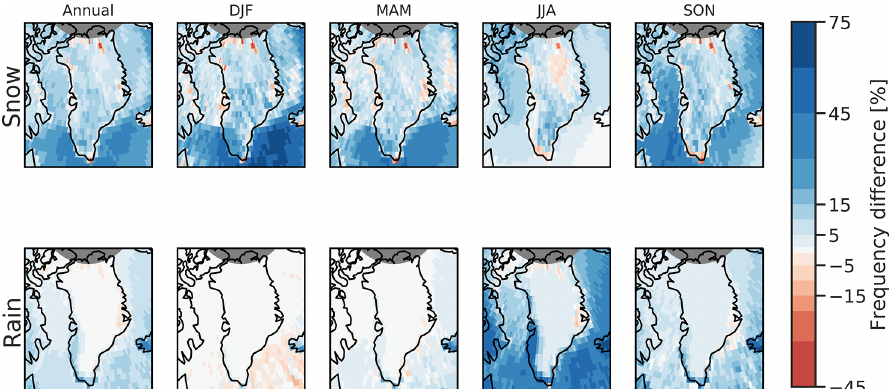
Figure 5. Present-day annual (left) and seasonal (DJF, MAM, JJA, SON, from left to right) mean snowfall (top) and rainfall (bottom) frequency difference between CESM (2006–2020) and CloudSat 2CPC (2006–2016). Positive values indicate that CESM overestimates precipitation frequency relative to